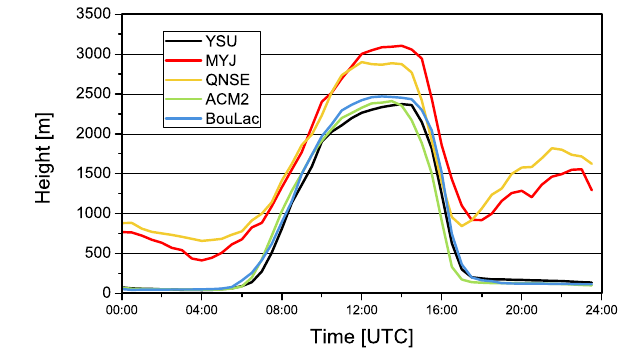
of PBL Figure 2. Average (July–September, 2012) diurnal course Figure 3. Average (July–September, 2012) diurnal course of PBL Figure 3. Average (July–September, 2012) diurnal course of PBL height derived from windprofiler and radiometer measurements. height using WRF-SCM model. height using the WRF-SCM model.